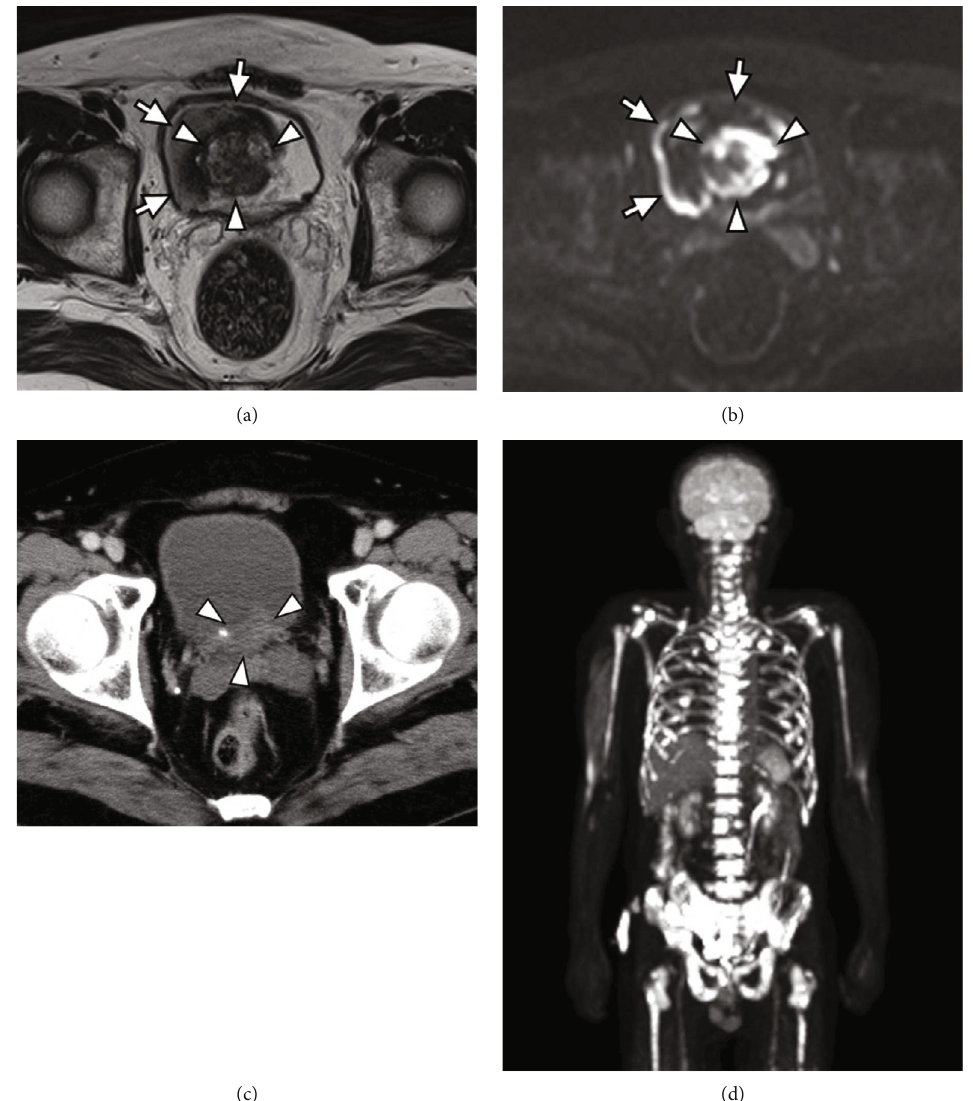
Figure 1: (a) MRI T2-weighted image and (b) di ff usion-weighted image showed a bladder tumor (white arrowheads) with hematoma (white arrows). (c) The CT image after NAC did not show rapid progression of the bladder tumor (white arrowheads). (d) The FDG-PET fi ndings when the patient presented with low back pain after the